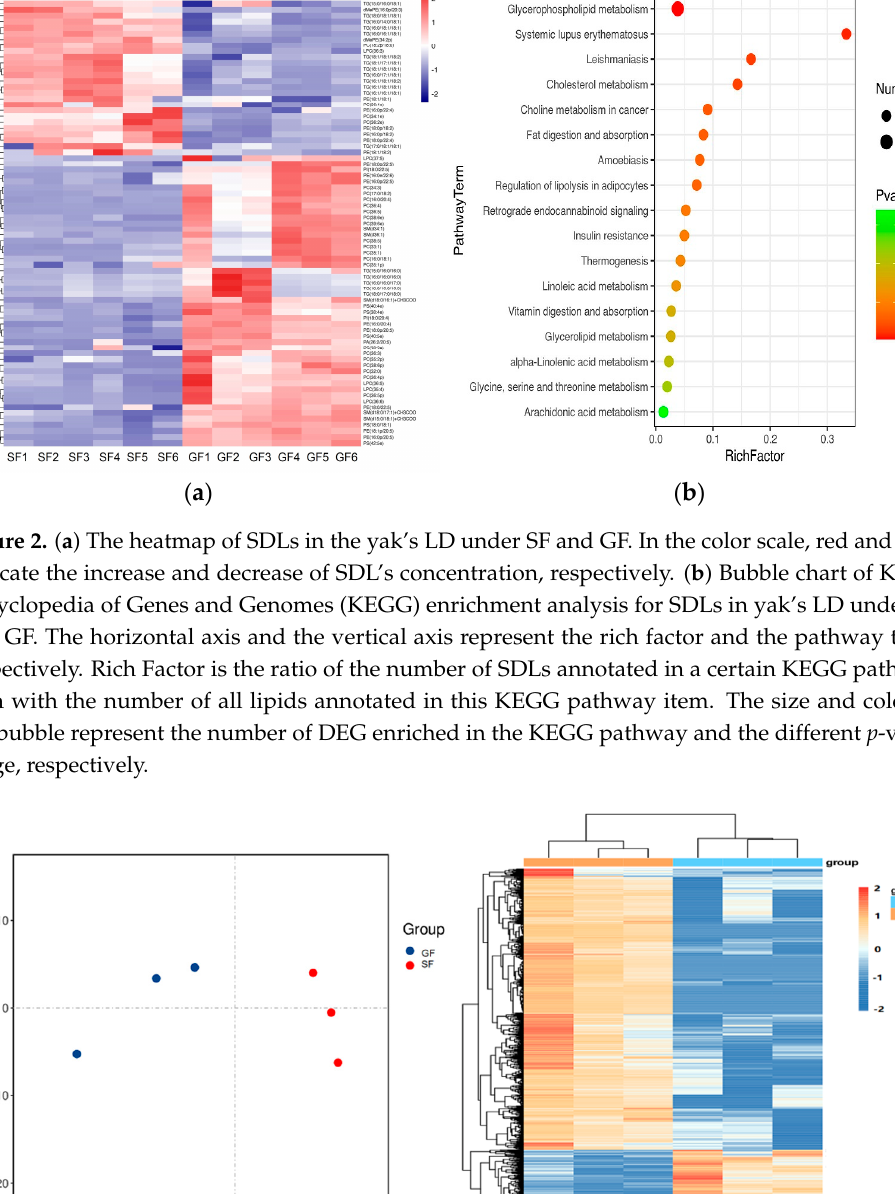
( d ) Figure 4. ( a ) The histogram of the Gene Ontology (GO) enrichment analysis of differentially ex- pressed genes (DEGs) in yak LD under GF and SF. The items of GO enrichment analysis are divided into biological processes (BPs), cellular components (CCs) and molecular functions (MFs). ( b ) The bubble chart of the KEGG pathway enrichment analysis of DEGs in yak’s LD under GF and SF. The